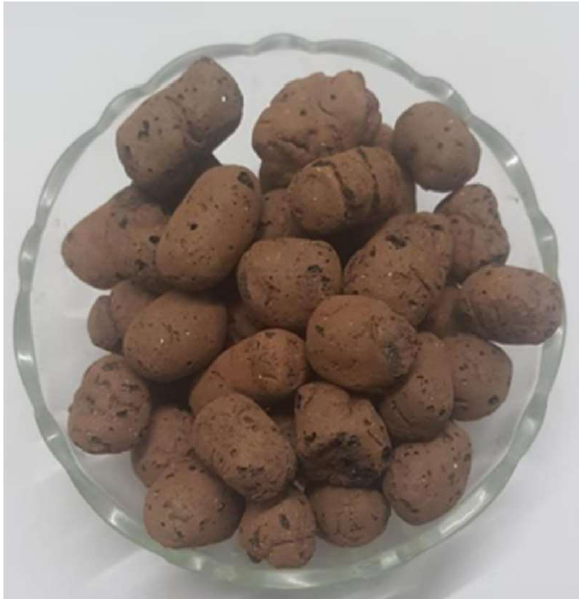
Figure 1. Expanded Clay Aggregate.